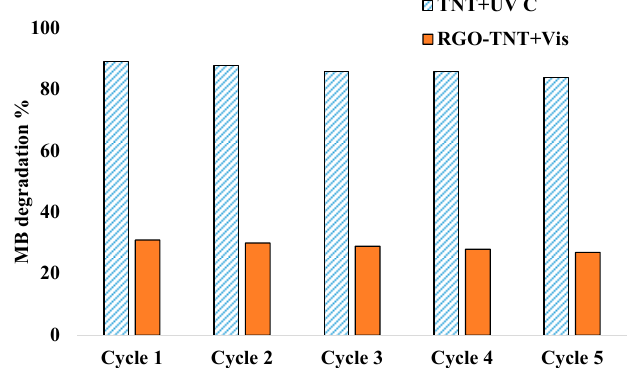
Figure 7. Recycling of TNTs + UV C and RGO ‐ TNTs + Vis light in a continuous ‐ flow experiment.